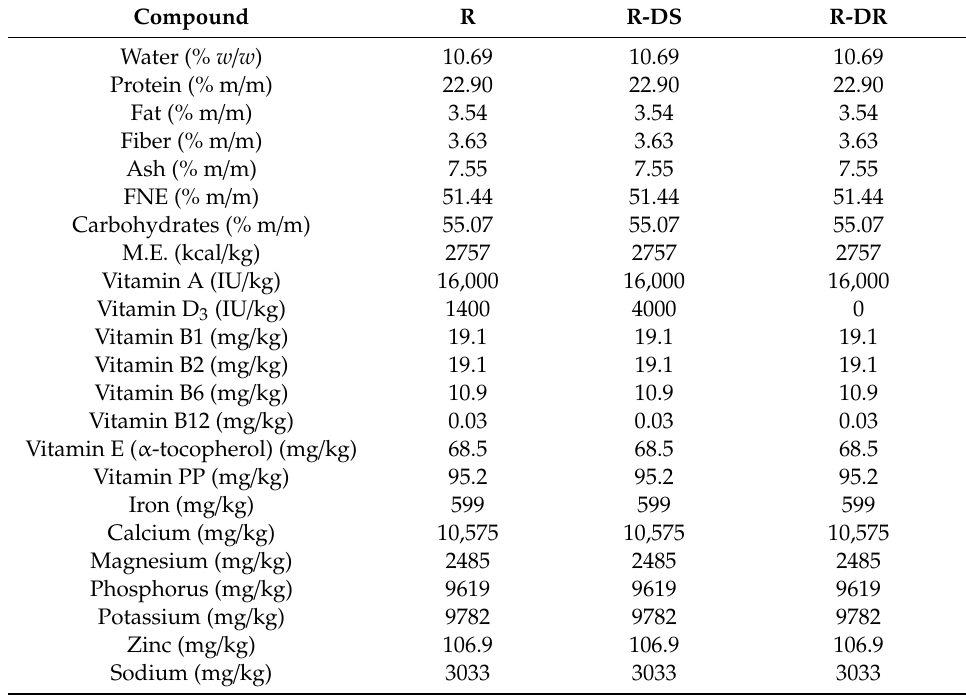
Table 1. The composition of the experimental